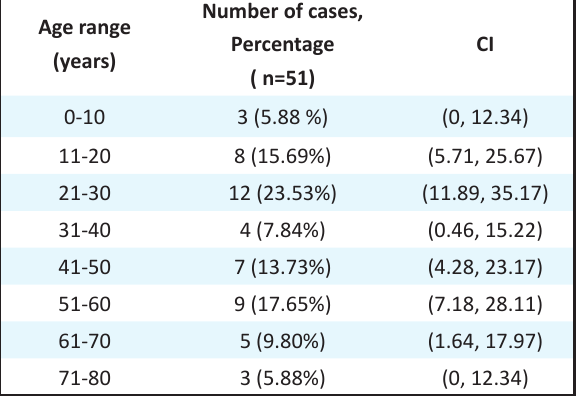
Table 1. Distribution of cases according to age.